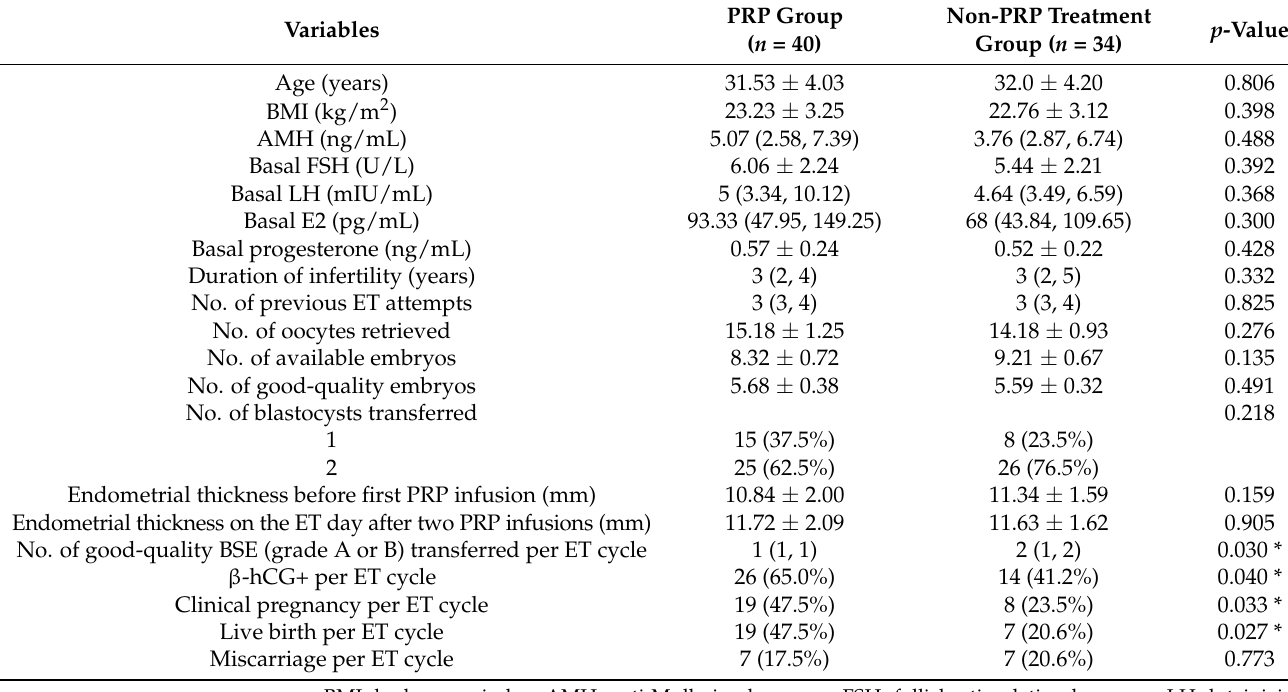
Table 2. Baseline characteristics and outcome variables of the blastocyst-stage-embryo group.